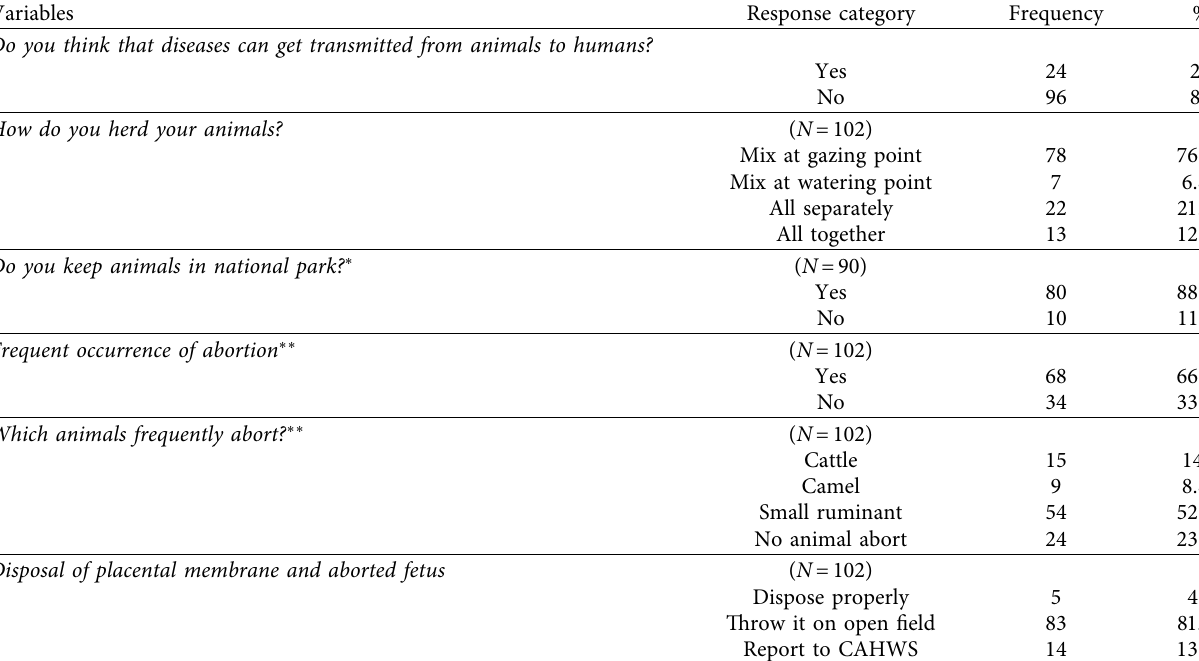
Table 6: Zoonotic disease knowledge and livestock keeping practice of pastoralists in the study area.